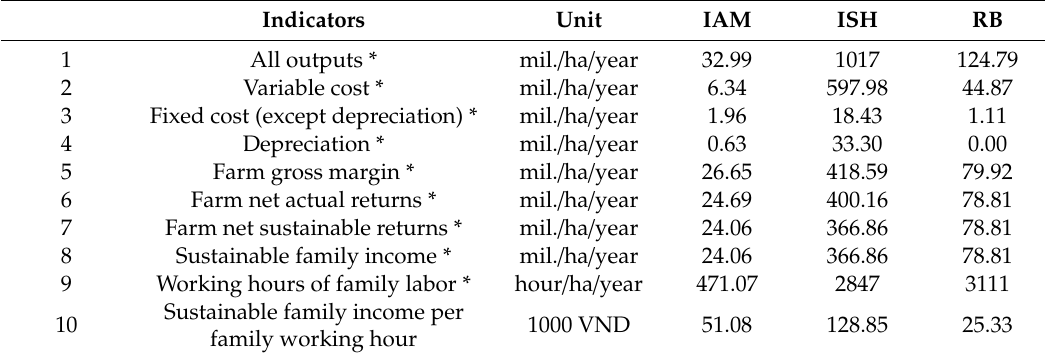
Table 6. Economic performance of farming